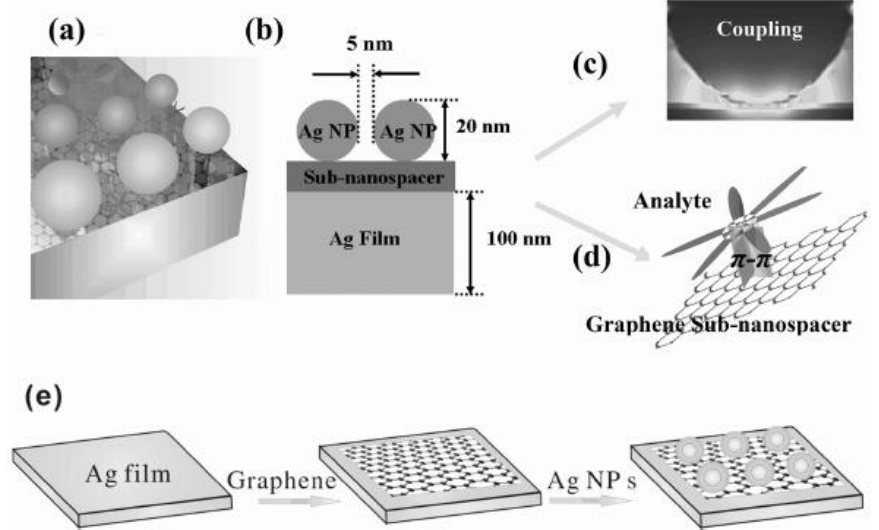
Figure 7. (a) 3-dimensional schematic of the G-NFG system. (b) Cross-sectional schematic of the G- G-NFG system. ( c ) Strong near-field due to NPs-film coupling. ( d ) Chemical mechanism NFG system. (c) Strong near-field due to NPs-film coupling. (d) Chemical mechanism enhancement. (e) Schematic of the fabrication process of the graphene separated G–NFG system. [66].